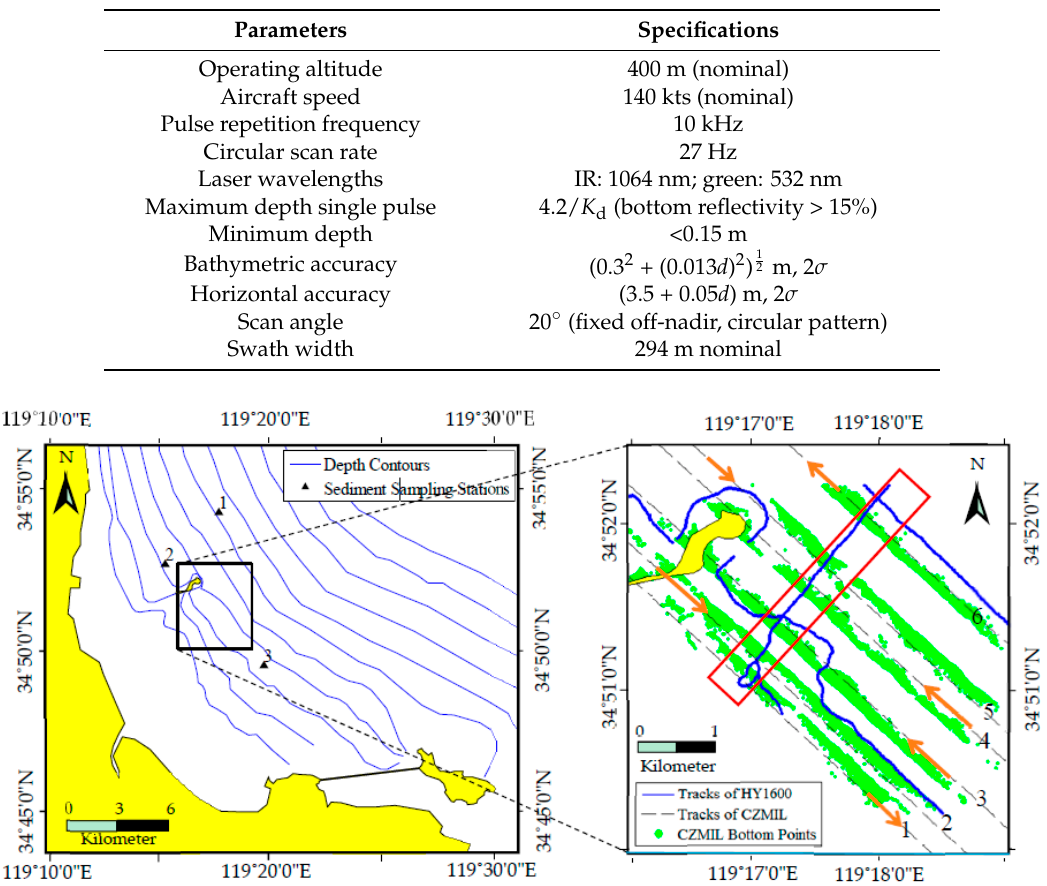
Table 1. Main technical parameters of CZMIL.